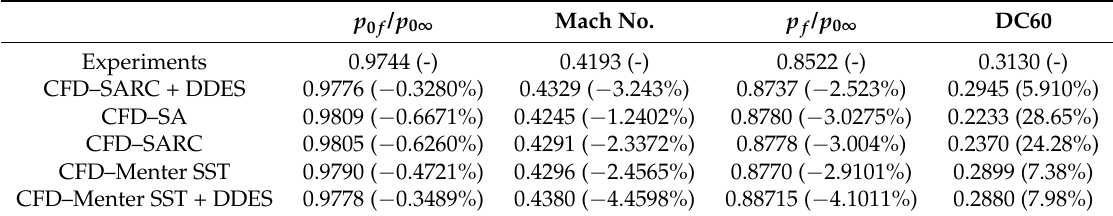
Table 4. Turbulence modeling effects on the RAE-M2129 baseline predictions. NASA grid was used. CFD data are time-averaged from 2 to 2.5 s of simulation